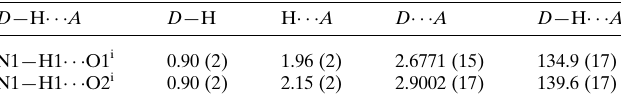
Table 2 Experimental